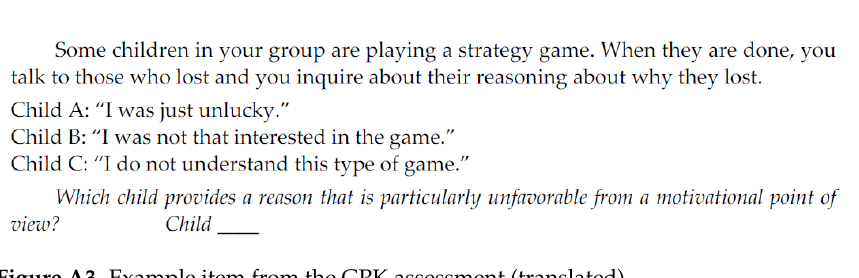
Figure A2. Example item from the MPCK test (translated).